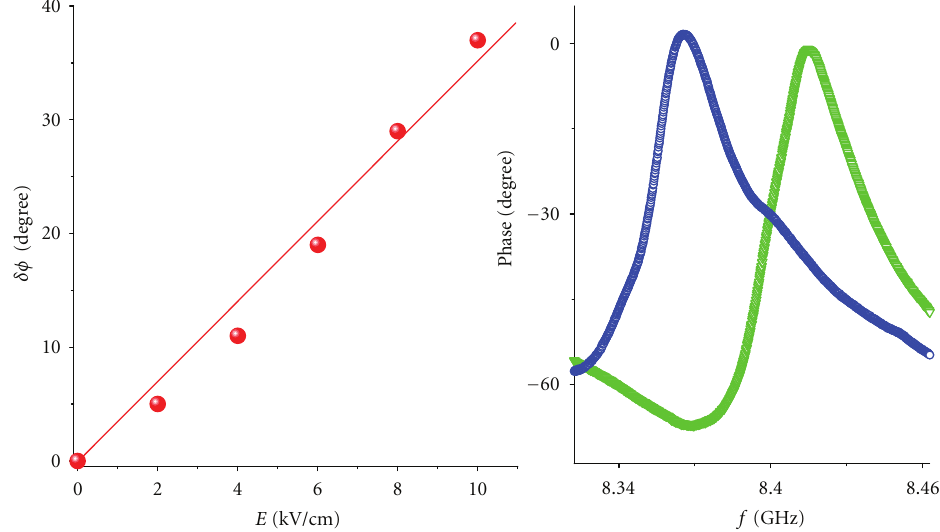
Figure 10: Di ff erential phase shift versus electric field E (left) and typical view of phase characteristics versus frequency (right). H is parallel to sample H 0 = 2277 Oe; L = − 4 dB; f 0 = 8420 MHz YIG 26.8 μ m; φ = 4 mm; t GGG = 440 μ m; PMN-PT 0.5 mm; φ = 6mm.